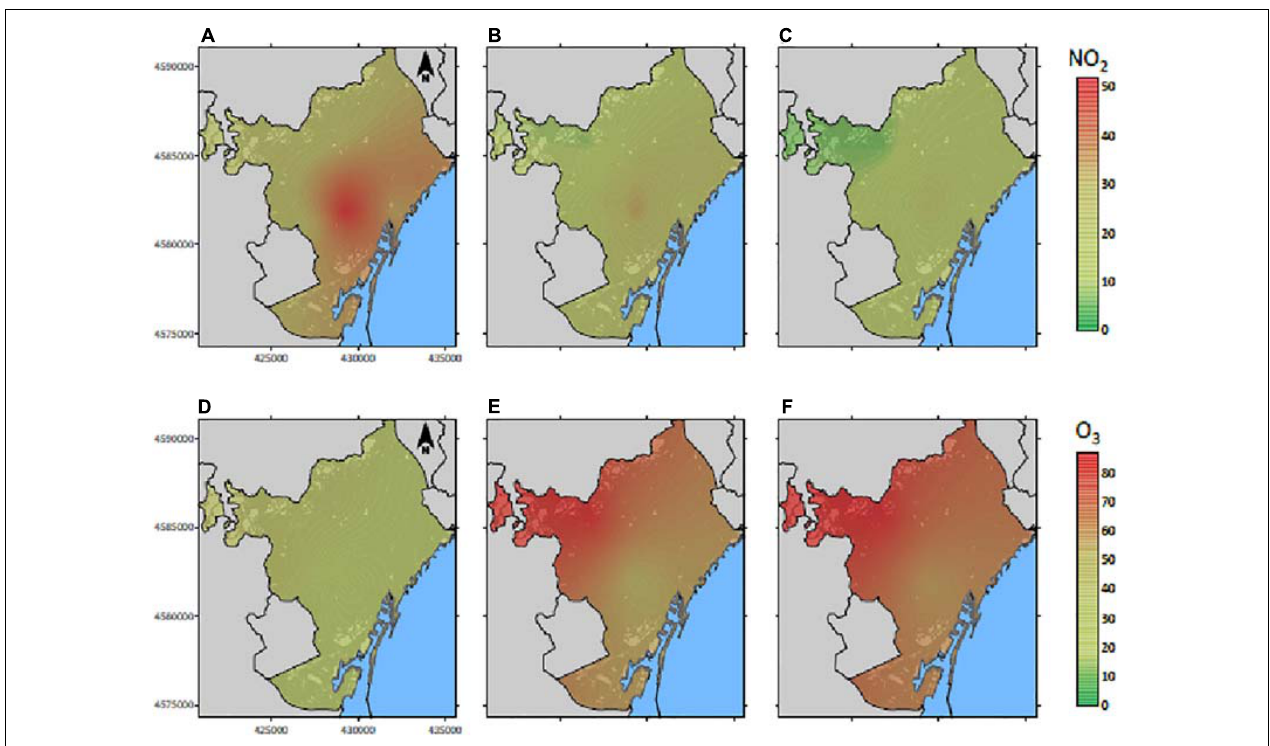
FIGURE 2 | Spatial distributions of airborne NO 2 (A–C) and O 3 (D–F) Barcelona, averaging in the B1 [15 October 2019–9 January 2020; (A,D) ], B2 [9 January 2020–15 July 2020; (B,E)] and specific lockdown [15 March 2020–22 June 2020; (C,F) ] periods. The plotted values ( µ g m - 3 ) are the averages of the daily measurements between 7 and 20 h. Note that the north and west zones are forested. From data of the air monitoring stations of the Catalan Government.